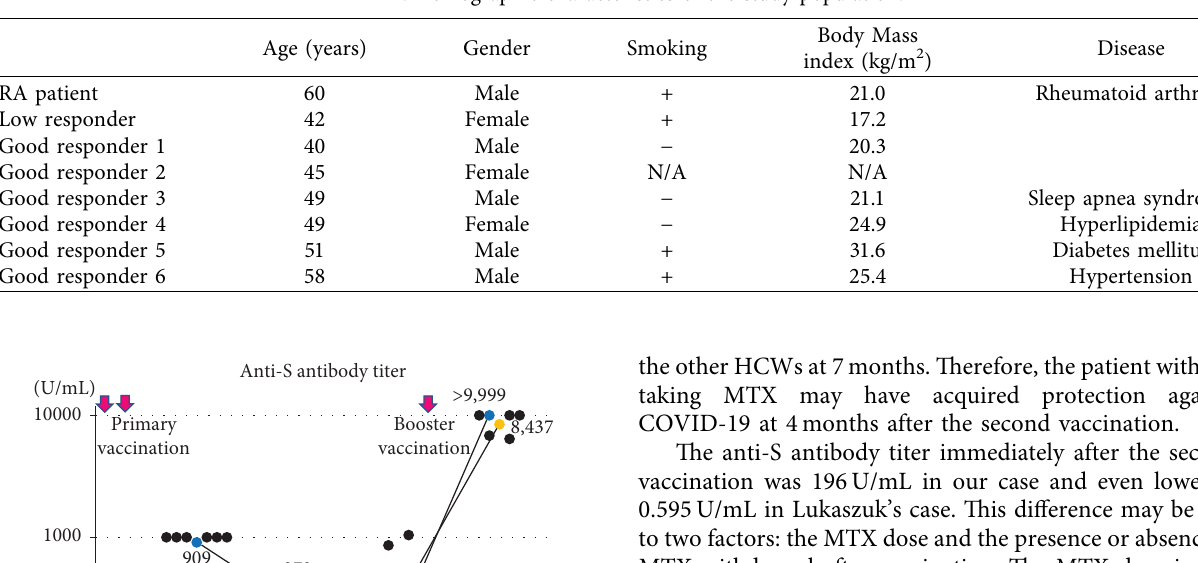
Table 1: Demographic characteristics of the study